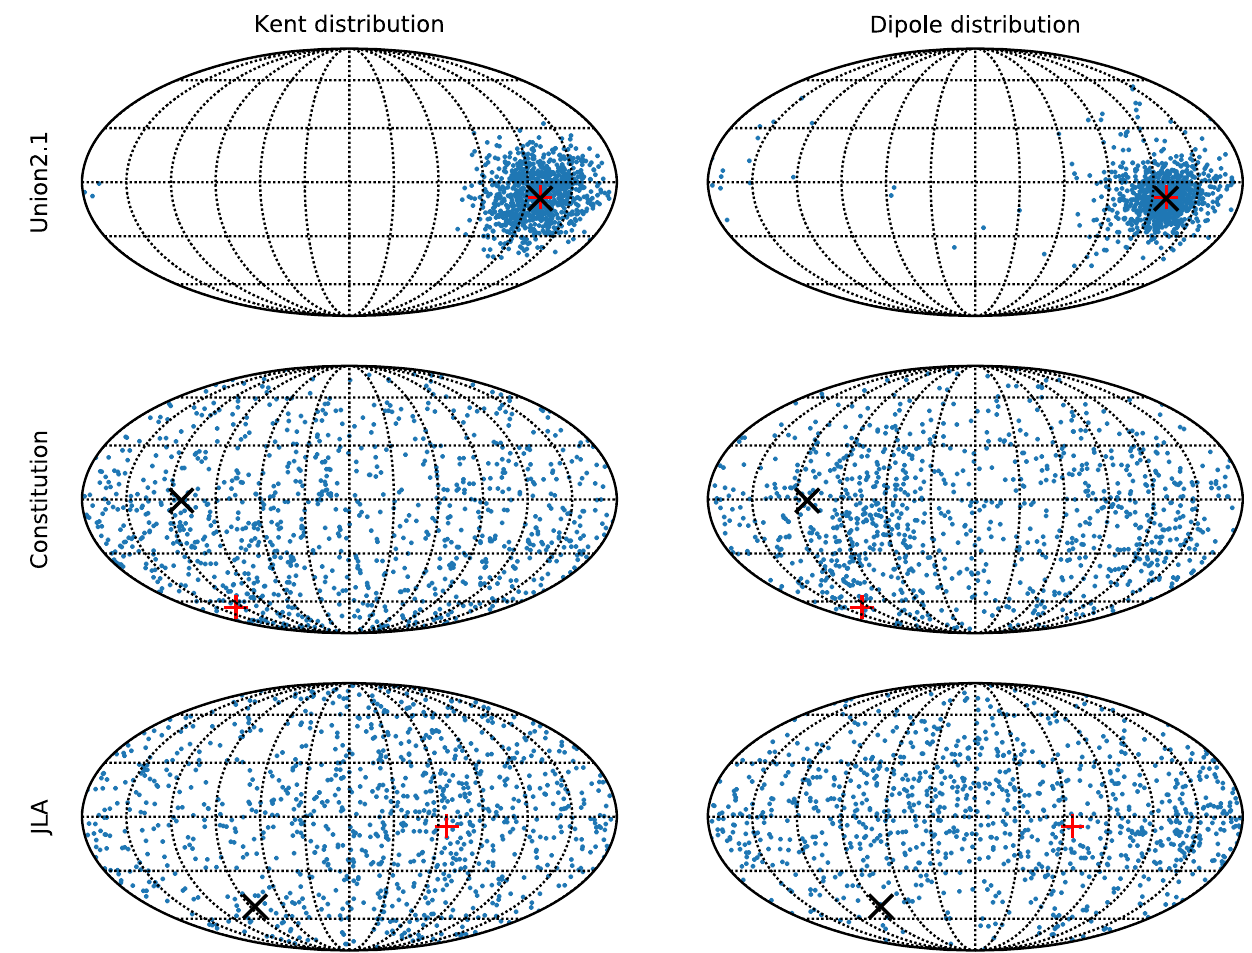
Fig. 13 Left column shows samples drawn from fitted Kent distribution, the right column shows original dipole positions. Black x-cross shows the center of Kent distribution. Red cruciform shows the position of the best-fitting